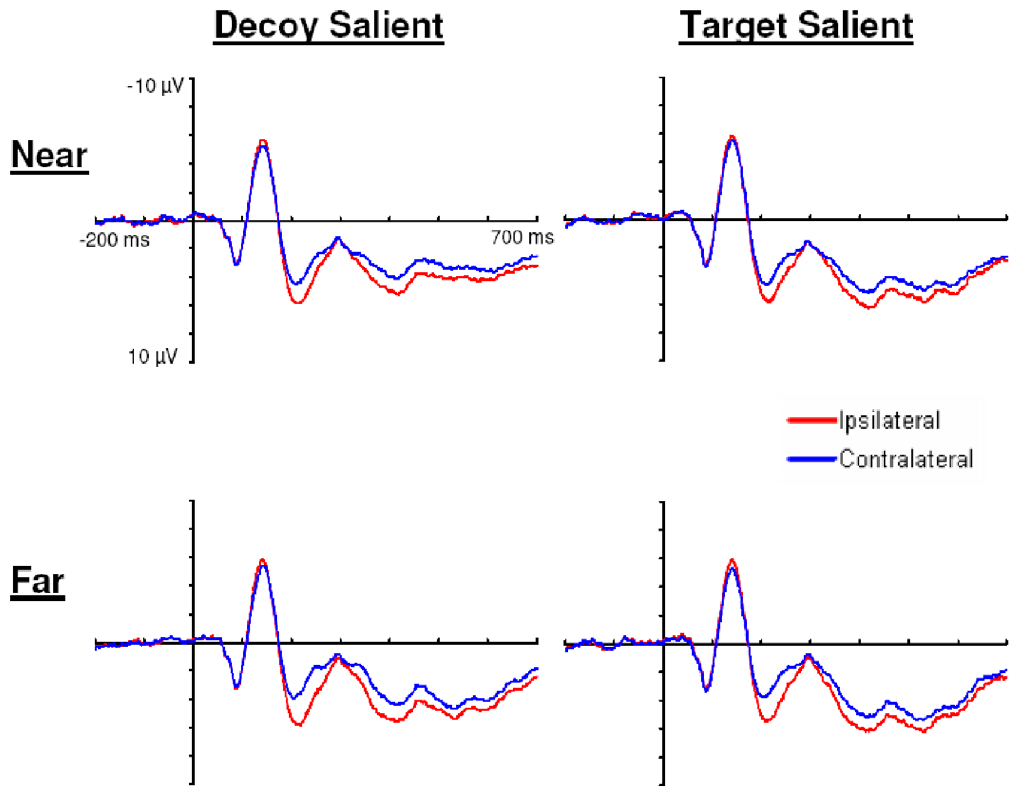
Figure 6. Ipsilateral and contralateral waveforms from Experiment 2. Displayed are the ipsilateral and contralateral grand average waveforms for electrodes PO3/4 at each level of target-decoy separation and relative salience in Experiment 2.